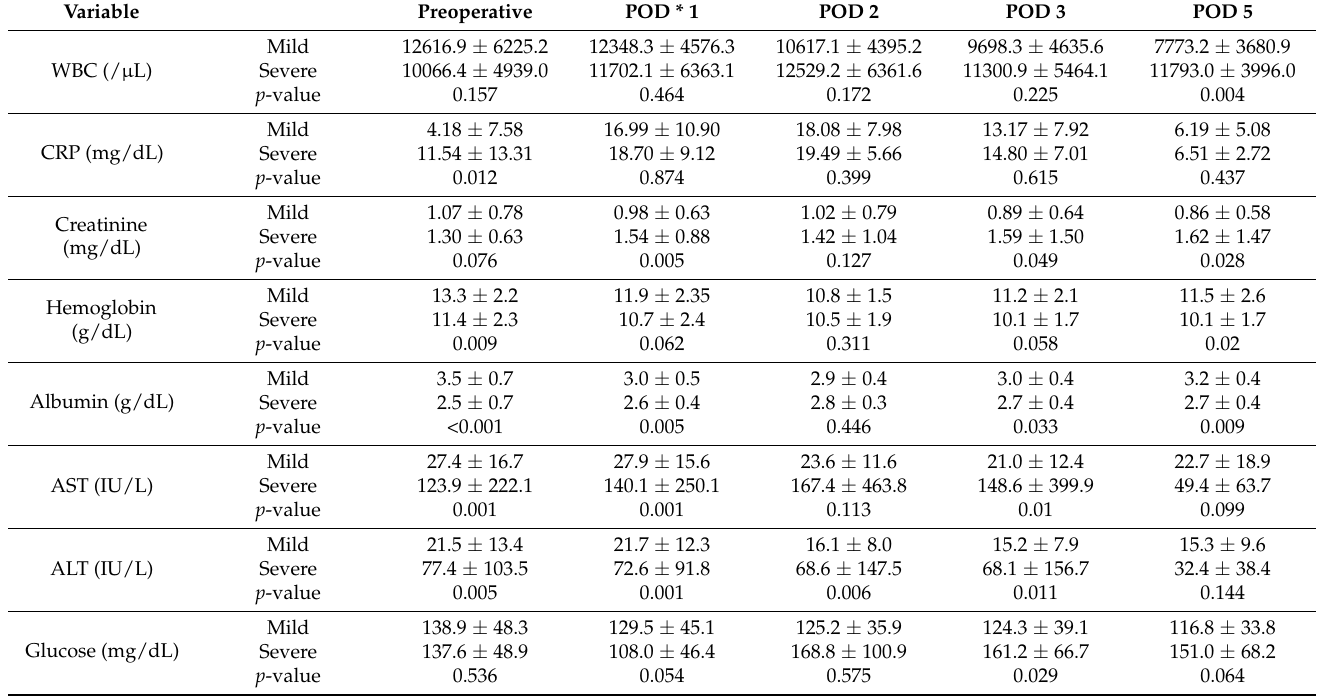
Table 4. Laboratory findings pre- and postoperatively, according to complication group.